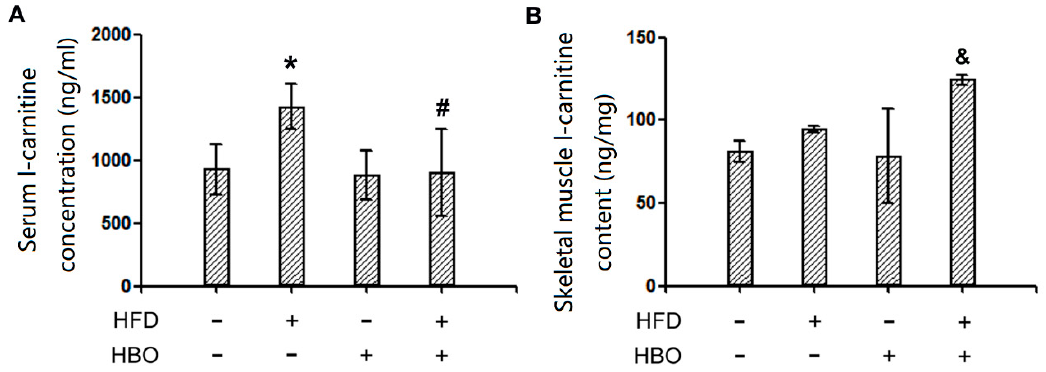
Figure 7. Serum and skeletal muscle L-carnitine levels. Serum and skeletal muscle L-carnitine levels were measured with LC-MS / MS. Please refer to supplementary materials for method and quality control details. Three to five samples from independent animals were included in the tests. Error bars represent standard derivation. ( A ): Serum L-carnitine levels. ( B ): Skeletal muscle L-carnitine levels. *: statistically different from control group animals ( p < 0.05). #: statistically different from HFD group animals ( p < 0.05). &: statistically different from HBO group animals ( p < 0.05).